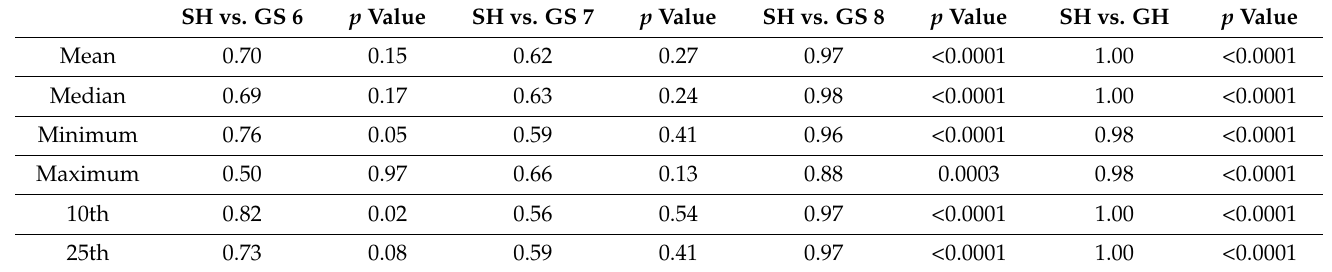
Table 2. Comparison of AUC values for used to differentiate tumor foci from stromal hyperplasia.